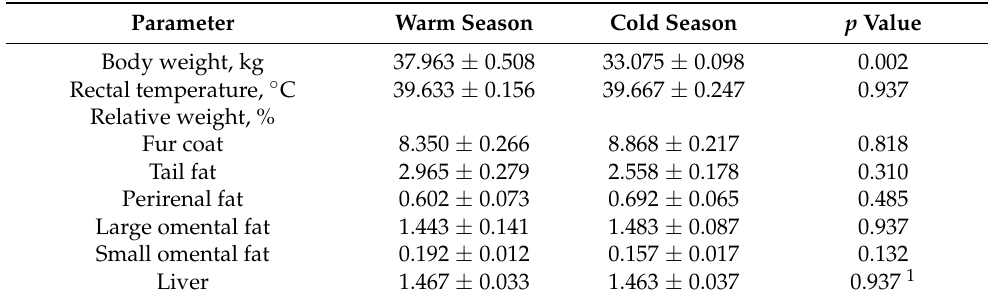
Table 3. Changes in body weight, rectal temperature, and relative fur coat, fat, and liver weights in grazing Mongolian